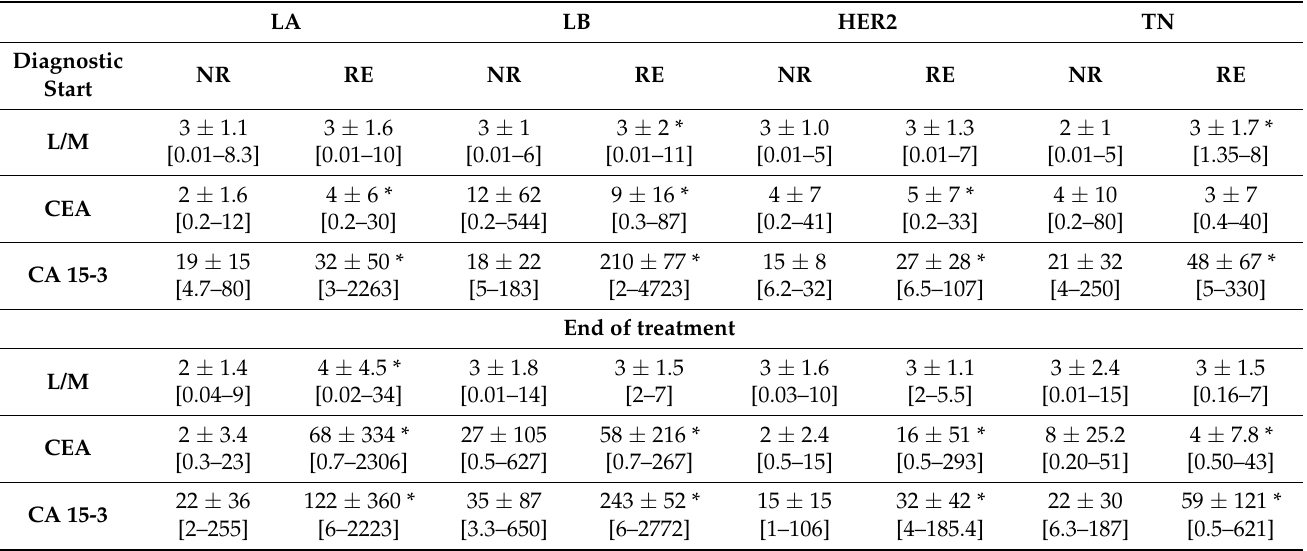
Table 4. Distribution of the L/M response and CEA and CA 15-3 antigens regarding the molecular type of breast cancer in Mexican